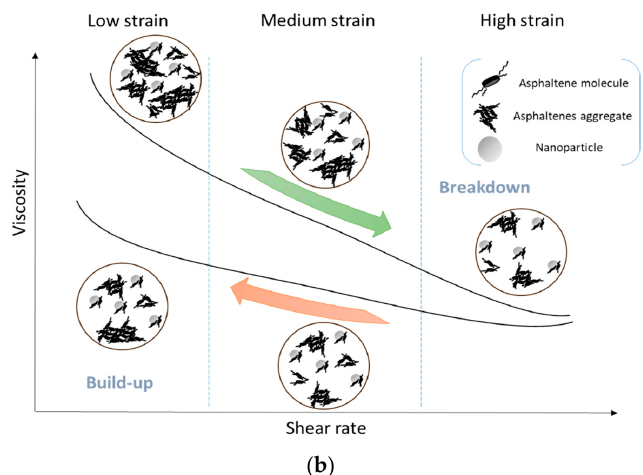
Figure 9. Hysteresis scheme representing the extra ‐ heavy oil (EHO) internal structure modification with the shear rate increase and decrease for ( a ) the EHO ‐ carrier fluid system and ( b ) the EHO ‐ nanofluid system.